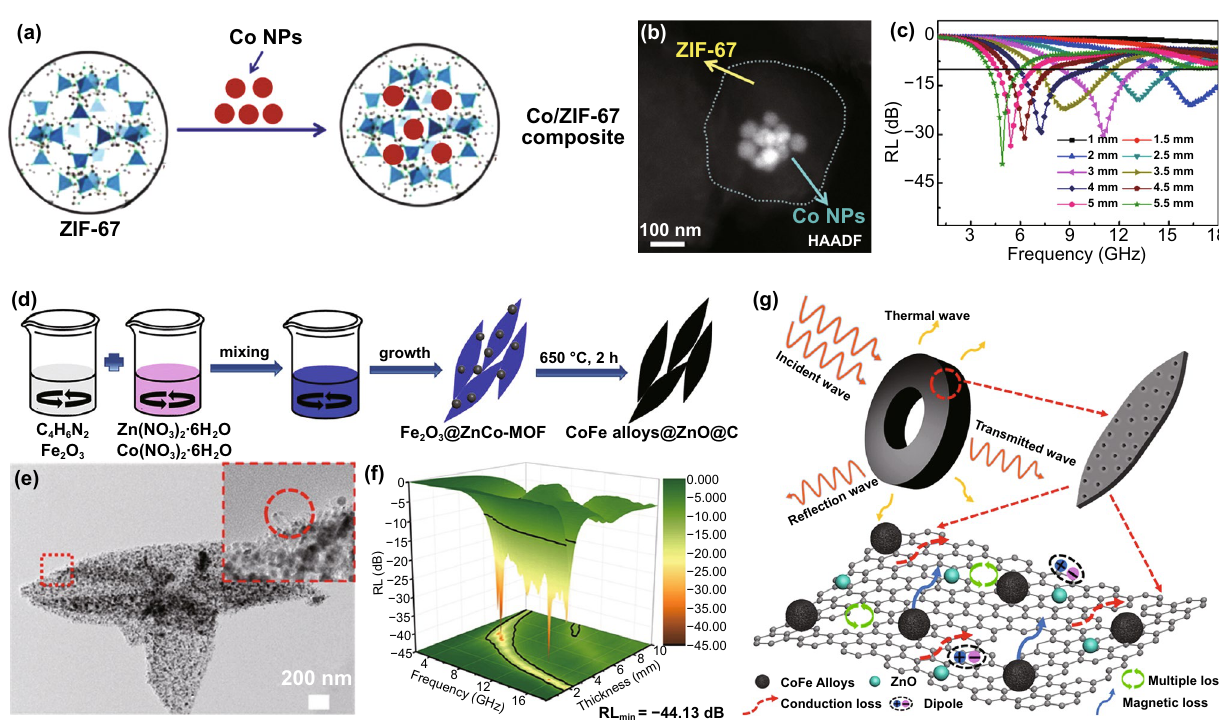
Fig. 12 a Schematic diagram of the fabrication and b HAADF image of Co NPs/ZIF-67, c RL-f curves of Co/C nanocomposites. Reprinted with permission from Ref. [125]. d Schematic illustration of experimental procedures e TEM and f RL-f curves of CoFe alloys@ZnO@C com- posites. g Schematic illustration of the MA mechanism of CoFe alloys@ZnO@C. Reprinted with permission from Ref.